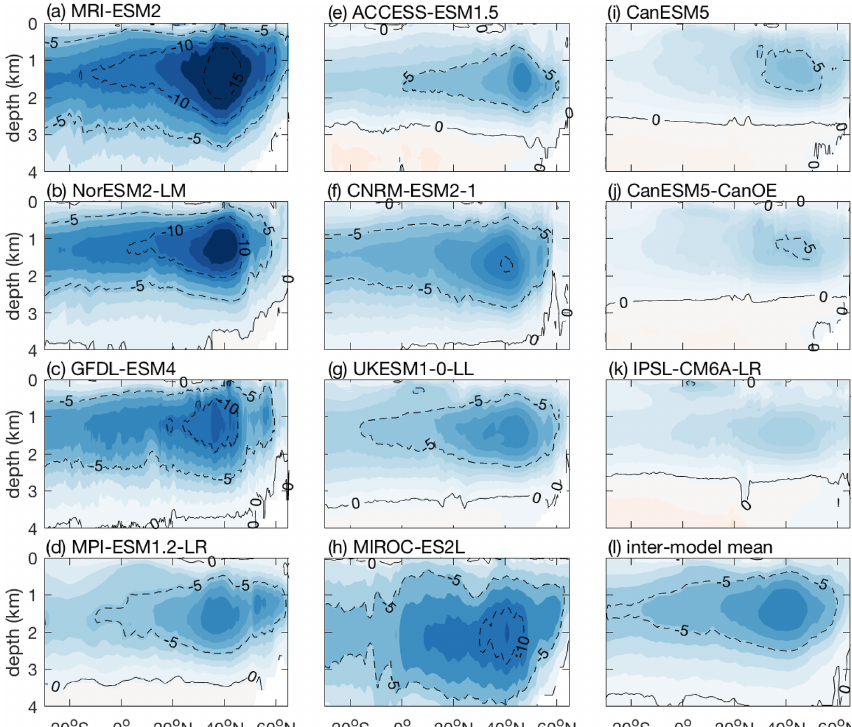
Figure 9. Weakening of the Atlantic Meridional Overturning Circulation (AMOC; Sv), relative to the pre-industrial era: (a–k) 11 CMIP6 Earth system models and (l) their inter-model mean. The estimates are based on the fully coupled simulation (COU) under the 1%yr − 1 increasing CO 2 experiment minus the pre-industrial control simulation (piControl). Diagnostics are from years 121 to 140 (the 20 years up to quadrupling of atmospheric CO 2